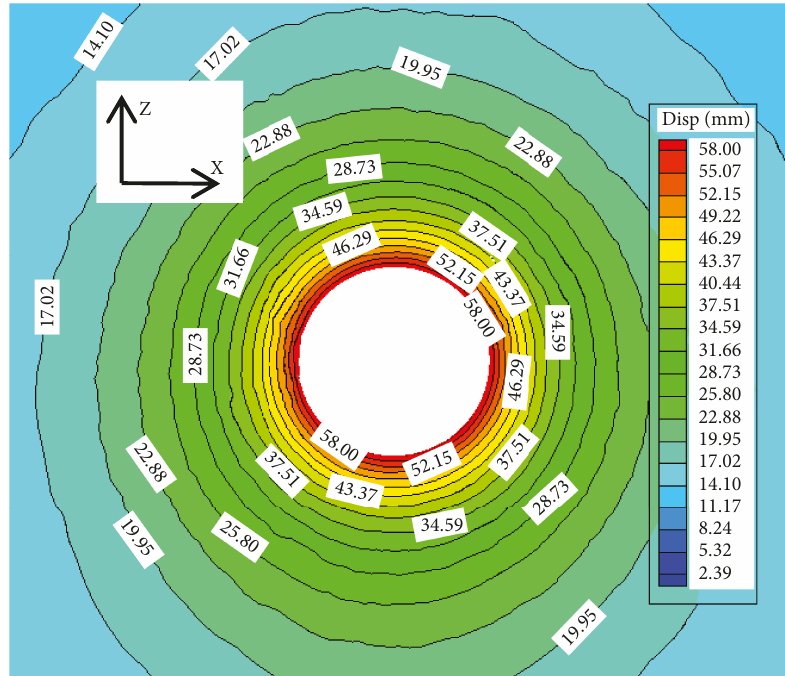
Figure 24: Resultant displacement of section C-C.